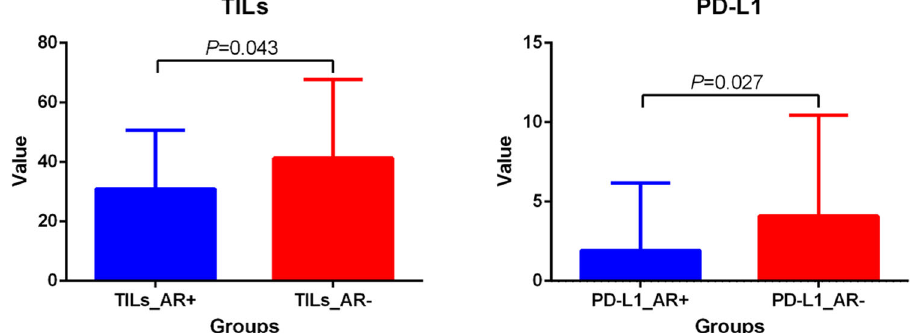
Fig. 6 TILs and PD-L1 distribution according to AR expression. Differential distribution of TILs and PD-L1 in matched AR + and AR − groups using the Wilcoxon signed-rank test. The boxes represent the median value, and the horizontal line represents the standard